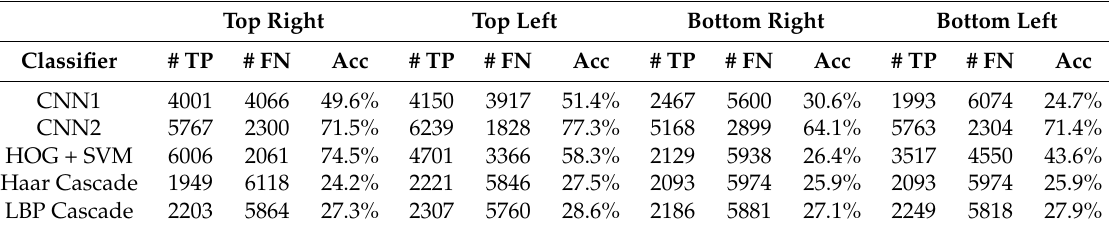
Table 4. Experiment results grouped by occlusion regions.